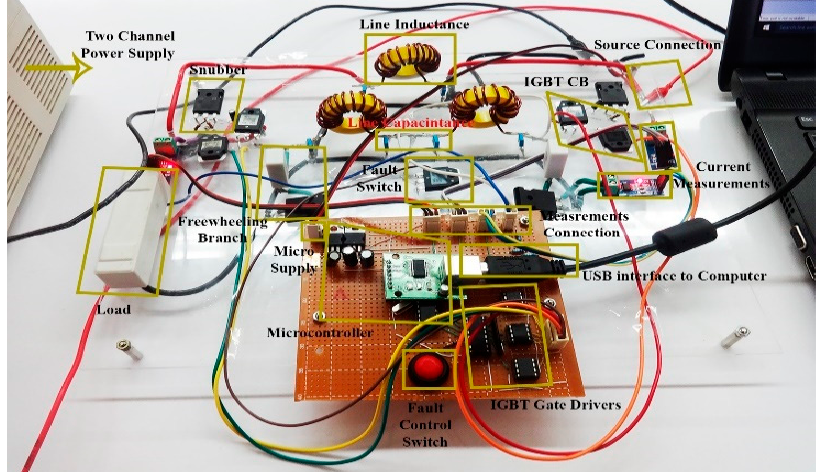
Figure 18. Experimental testbed, microcontroller board, and IGBTs gate drivers.